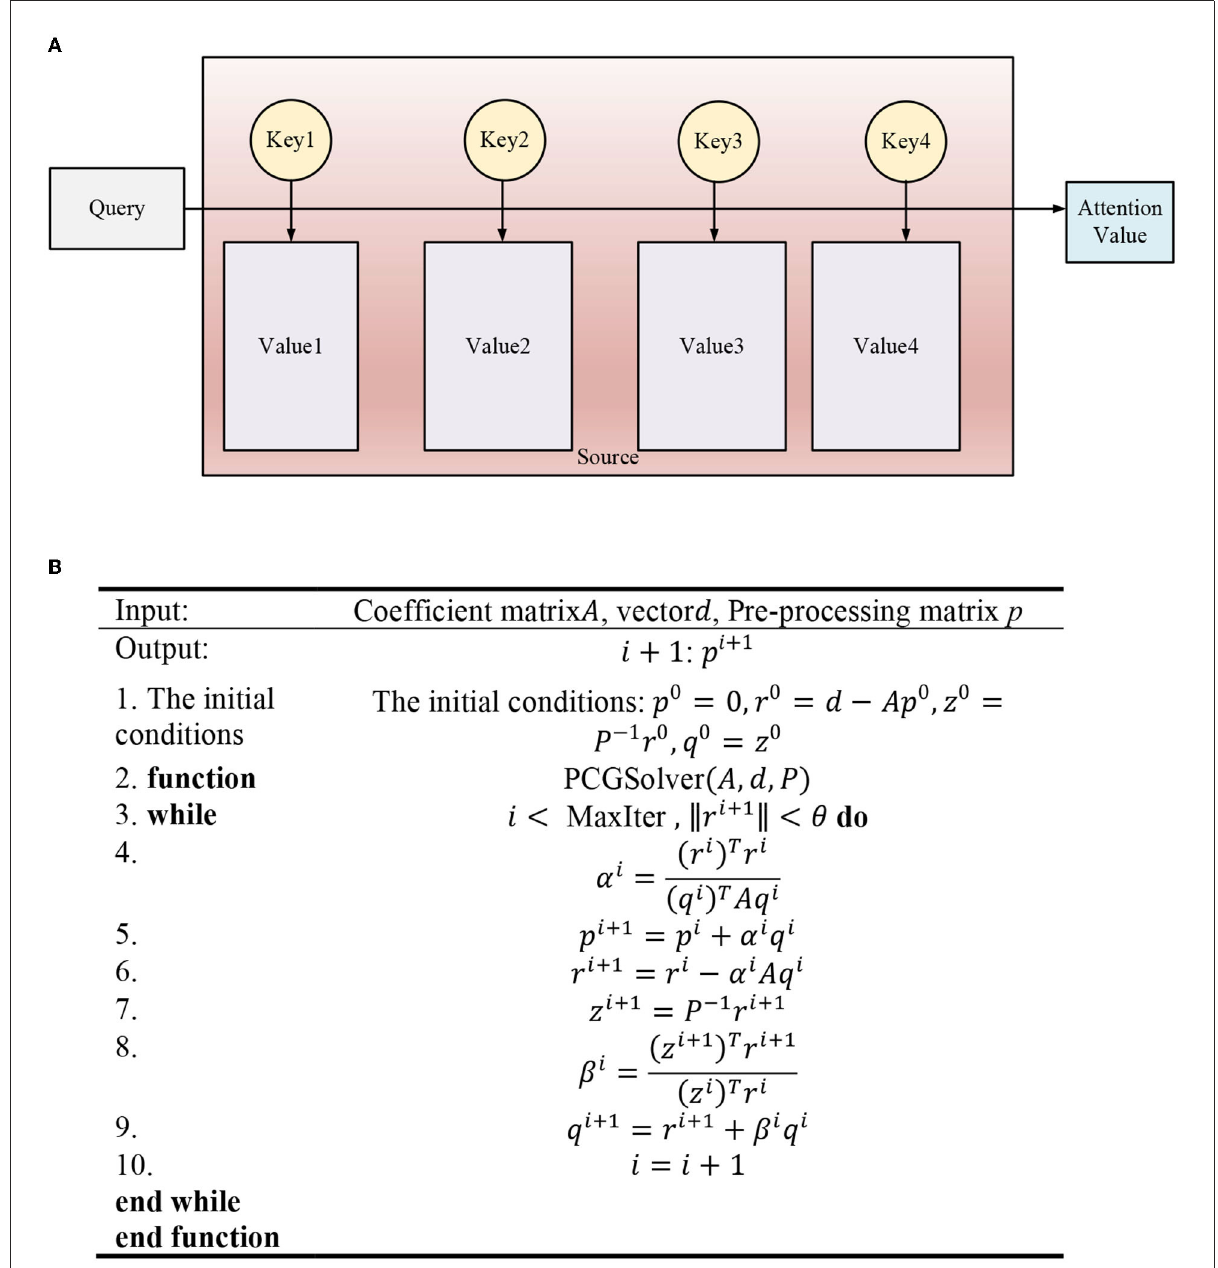
FIGURE5 Thought of AM. (A) Network structure, (B) Algorithm